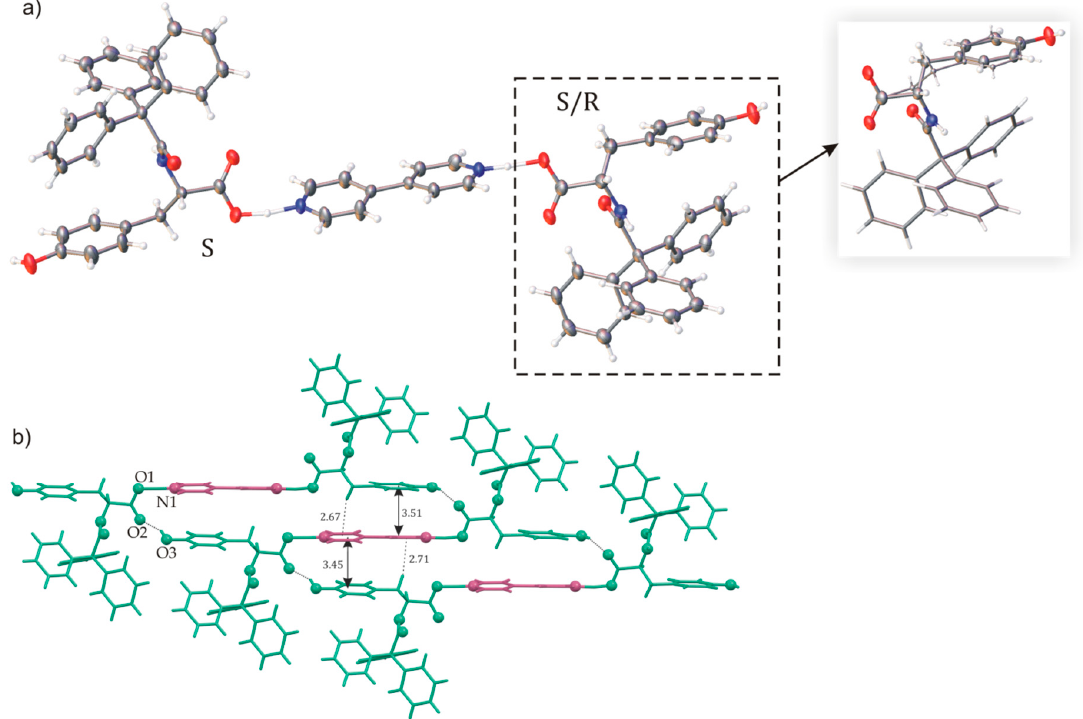
Figure 7. ( a ) Molecular structure of (TrCOTyr) 2 · BIPY (compound crystallizes as solid solution of enantiomers – model of disorder for the asymmetric molecule shown in the frame, minor position indicated by thinner bonds), displacement ellipsoids shown at the 50% probability level; ( b ) molecular tape stabilized by hydrogen bonds and π···π interaction. Distances are in angstroms.